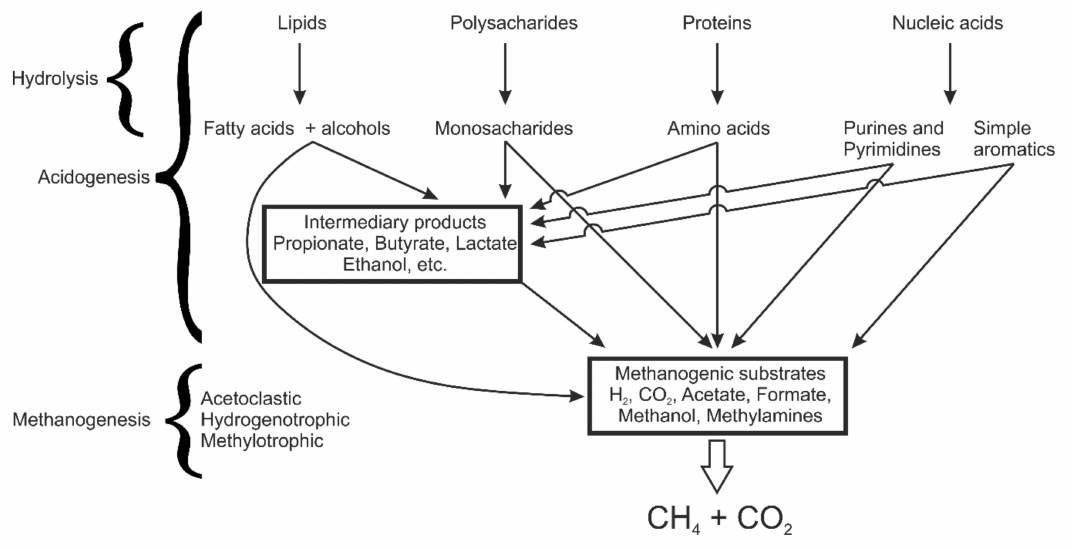
Figure 3. Scheme of reactions during anaerobic decomposition of polymeric materials [45], edited by